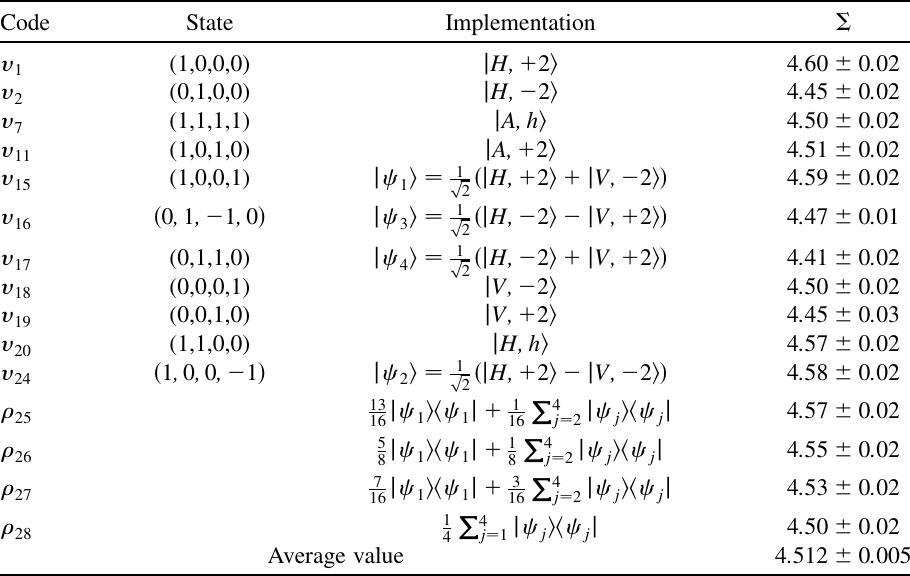
TABLE I. Experimental results for (cid:2) for 15 quantum states. Each input state is projected onto each of the 18 states in Fig. 1(a). Notation for this Table includes j A i ¼ j H iþj V i ffiffi jþ 2 iþj(cid:5) 2 i ffiffi p . The error bars are evaluated by considering the Poissonian statistics of coincidence 2 counts. All reported values lie in the range ½ (cid:2) min ; (cid:2) max (cid:6) (see Fig. 3).